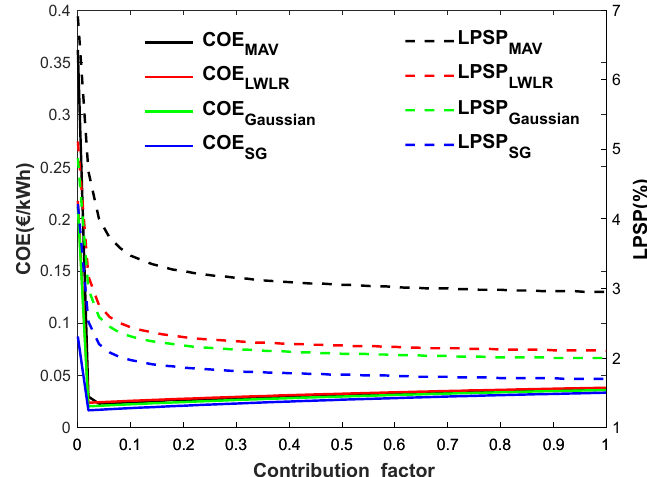
Figure 9. COE and LPSP for various contributing factors.